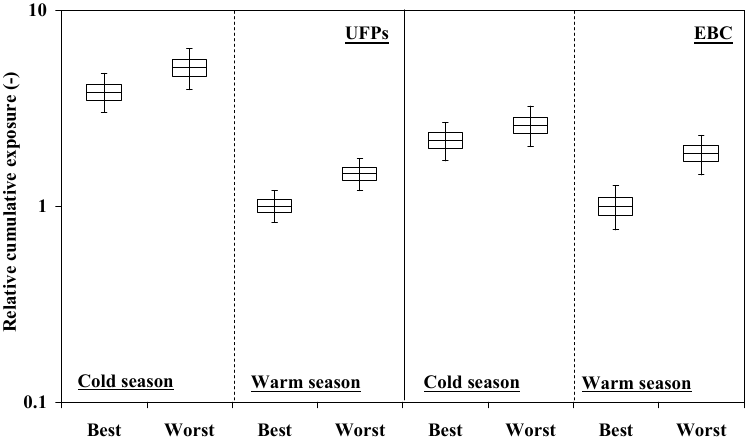
Figure 8. Box-plots of computed cumulative exposure to UFPs and EBC for best- and worst-case route choice for a commuter’s ride in the urban area (mean values: dots; min-max range: whiskers: median and interquartile range: boxes.).